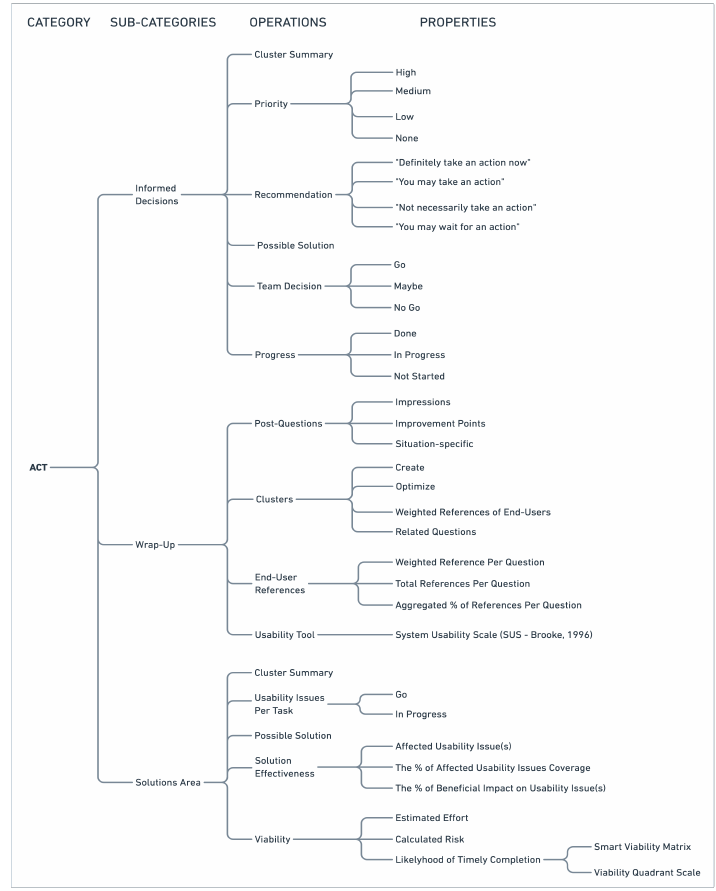
Figure 4. The act category, sub-categories, operations, and